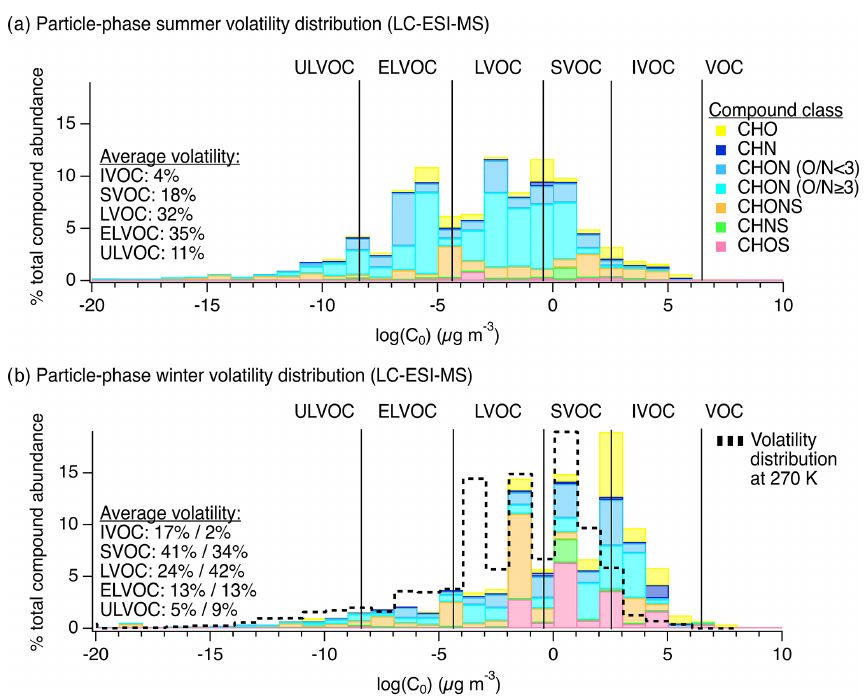
Figure 2. Chemical composition of particle-phase organic compound mixtures at the YCFS from LC-ESI-MS measurements. Panels (a) and (b) show particle-phase volatility distributions by compound class in the summer ( N = 34) and winter ( N = 15), respectively, weighted by ion abundance. The same data tallied by occurrence are shown in Fig. S4 for comparison. For direct comparison, volatility bins were defined for the same reference temperature in (a) and (b) (i.e., 300K, the average summertime sampling period temperature), though wintertime saturation mass concentrations for the observed compounds would shift approximately 2 orders of magnitude lower due to lower temperatures (i.e., 270K). The dotted black line in (b) shows the shift in bins expected at 270K, described further in Table S4. The average volatility distributions listed in (b) are shown at 300K (%) followed by the estimate at 270K